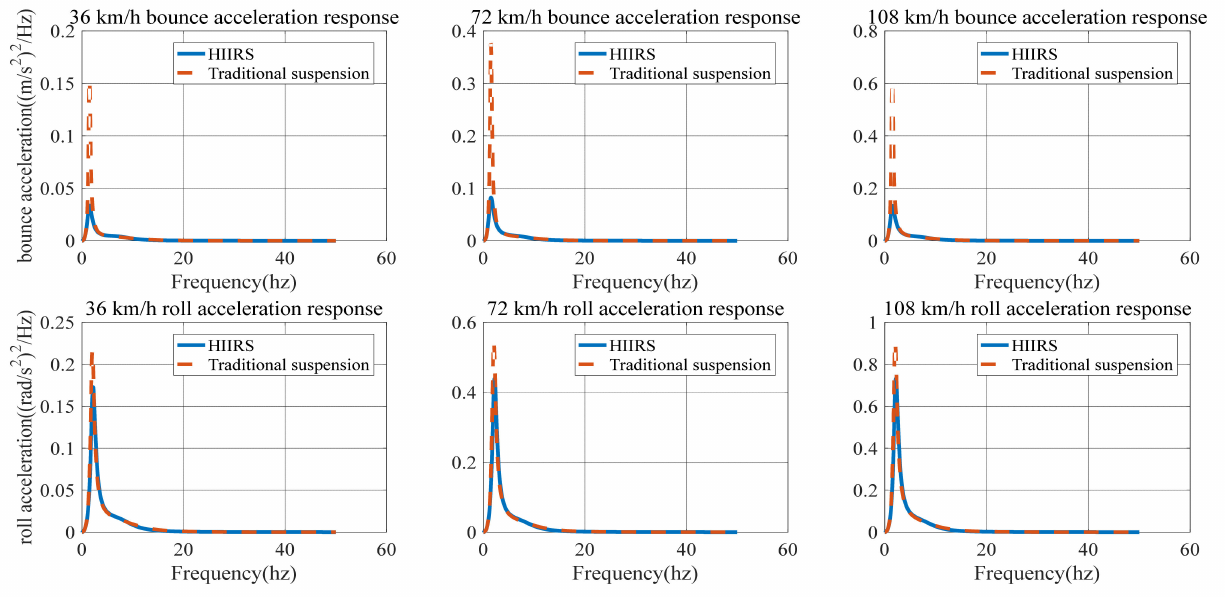
Figure 9. Comparison of bounce/roll acceleration between the HIIRS-equipped vehicle and the traditional vehicle when driven at 36, 72 and 108 km/h on Class-B